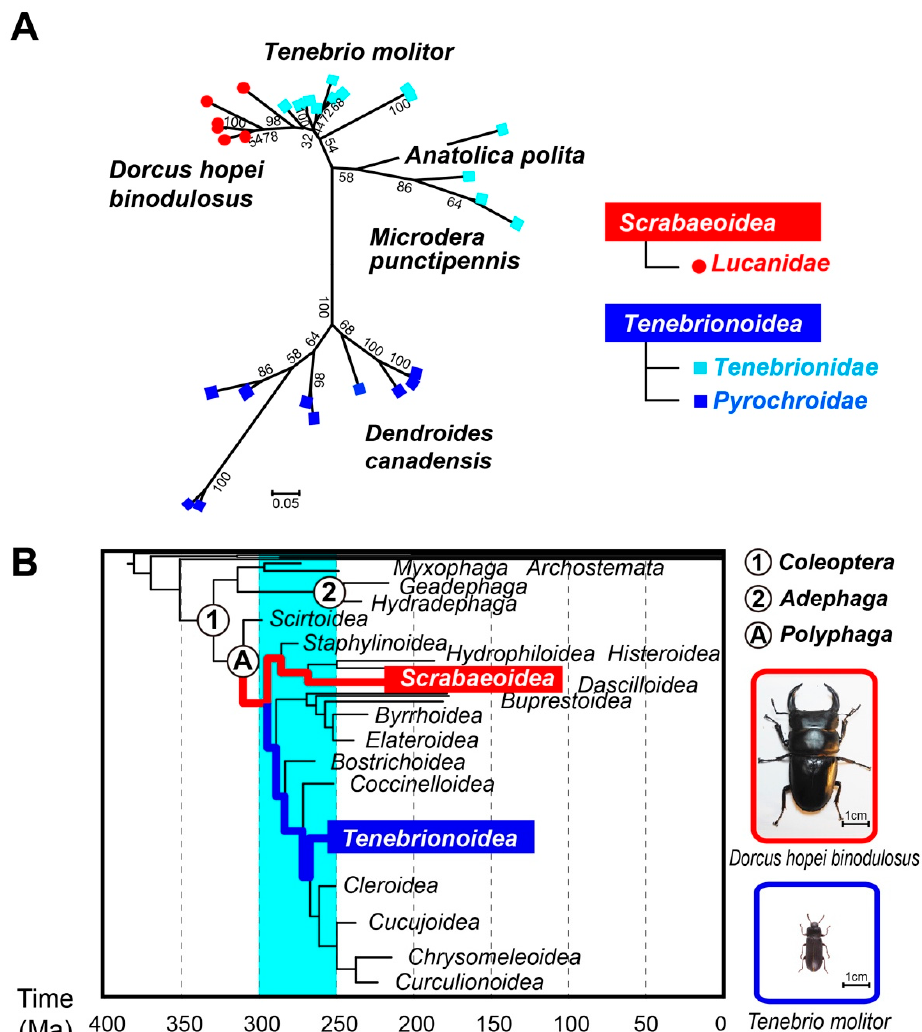
Figure 5. Phylogenetic relationship between the beetles synthesizing the hyperactive AFP com- posed of the consensus sequence TCTxSxNCxxAx. ( A ) Maximum likelihood phylogram showing a hypothetical relationship among the beetles based on analysis of a mRNA sequence alignment.